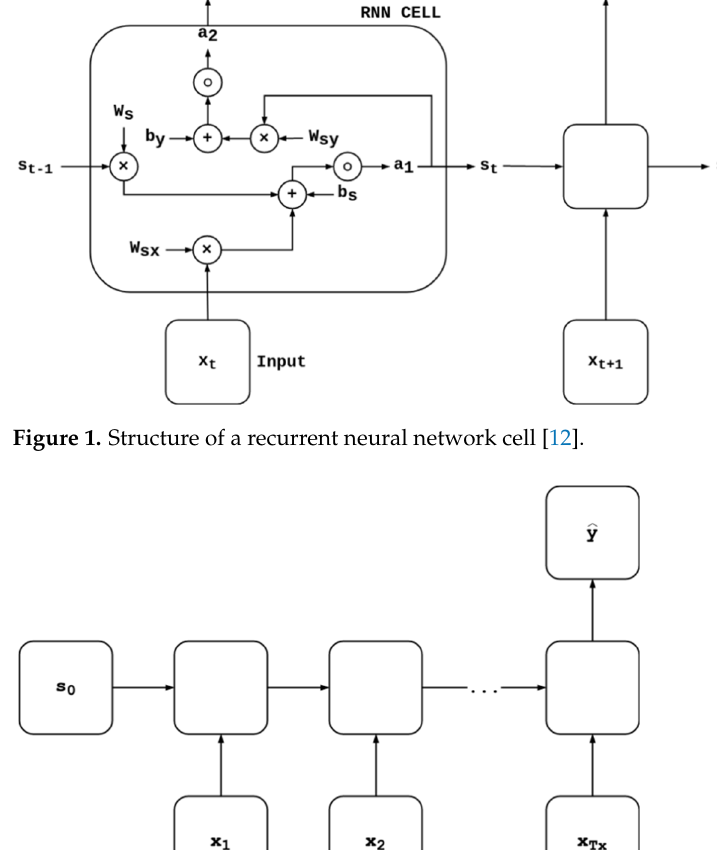
Figure 2. Recurrent neural network many-to-one architecture [12].